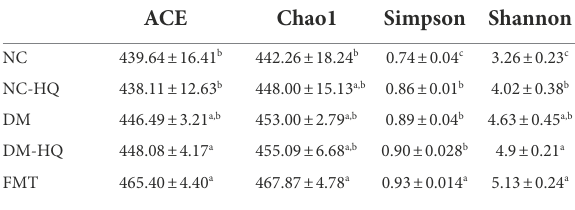
TABLE 2 Effects of FMT on α diversity of cecal microbiota in diabetic